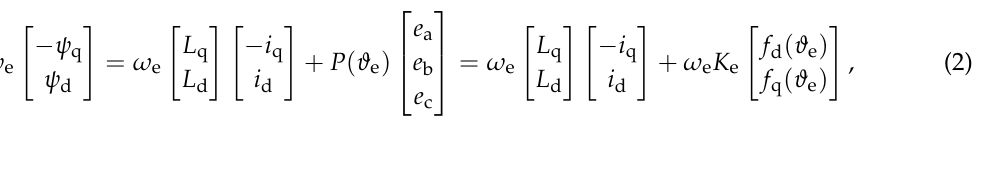
Figure 1. ( a ) Measured phase Back-EMF voltage, ( b ) FFT analysis of Back-EMF voltage, n r = 750